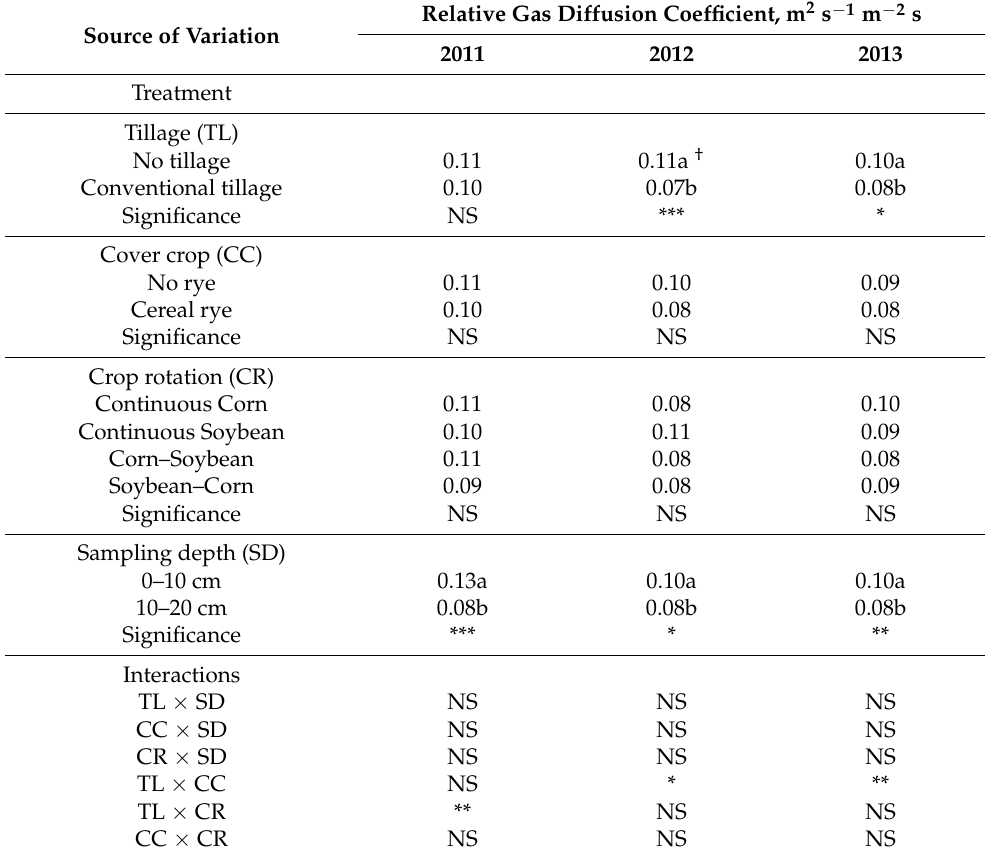
Table 2. ANOVA results with means for relative gas diffusion coefficient as affected by tillage system, cover crop, crop rotation and sampling depth and their